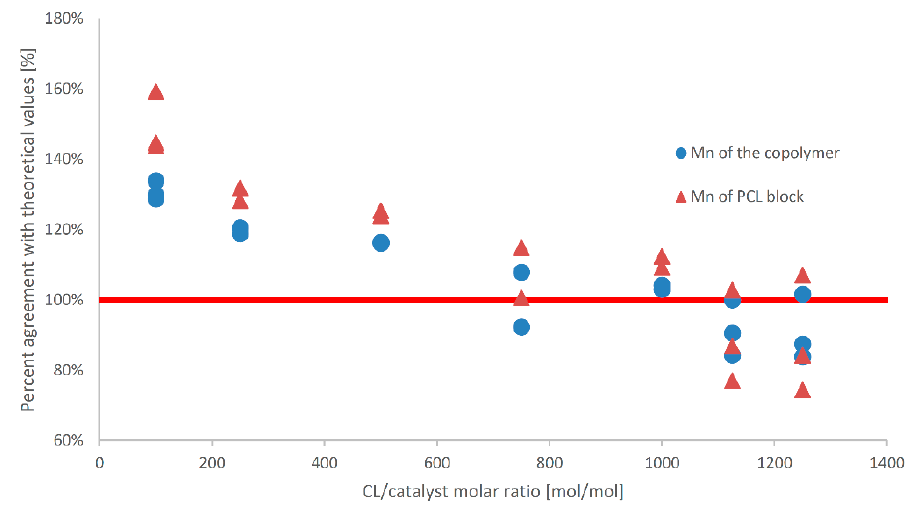
Figure 5. The percent agreement of M n of the copolymers and the PCL block versus CL/catalyst molar ratio.